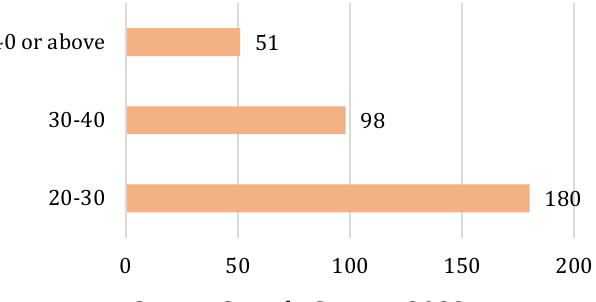
Source : Sample Survey, 2022